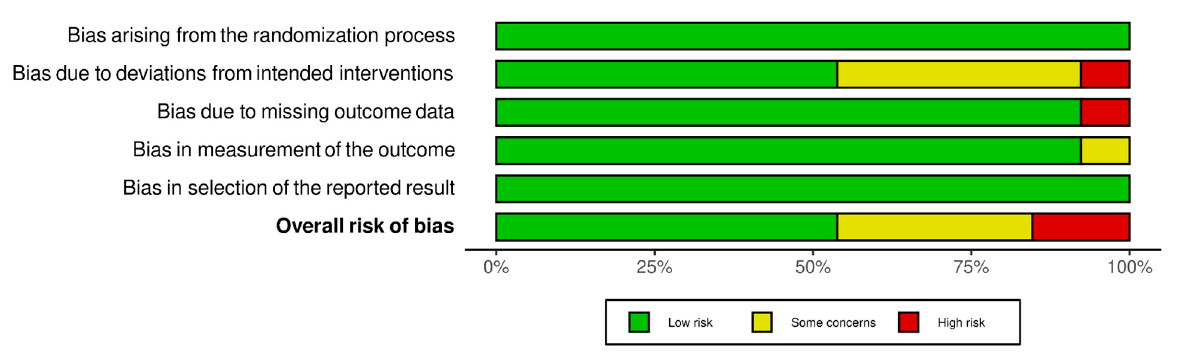
Figure 2. Traffic light plot’s risk of bias [7,12–23].